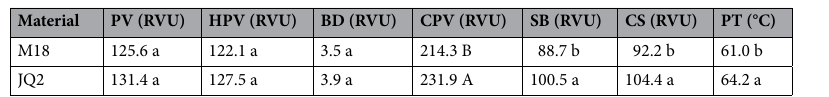
Table 2. The pasting viscosity parameters of Tartary buckwheat. PV peak viscosity, HPV hot paste viscosity, BD breakdown, CPV cool paste viscosity, CS consistency, PT pasting temperature. Different uppercase and lowercase indicate the significant difference between M18 and the control variety at 0.05 and 0.01, respectively, according to independent samples t -test (n = 3).